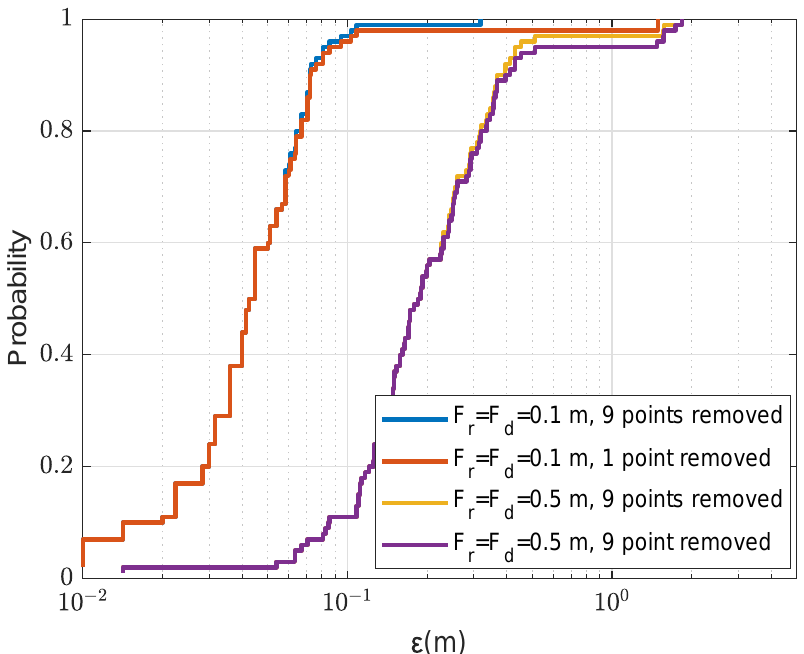
Figure 16. CDF for the localization error ε in the acoustic environment with the SWellEx-96 SSP against refined steps F r = F d ; N T = 4; N max = 4, after finding the AF maximum, two cases considered, one point and nine points are removed from the coarse grid map as described in Section 3.3; the refinement area is S f = 4 m × 4 m (as shown in Figure